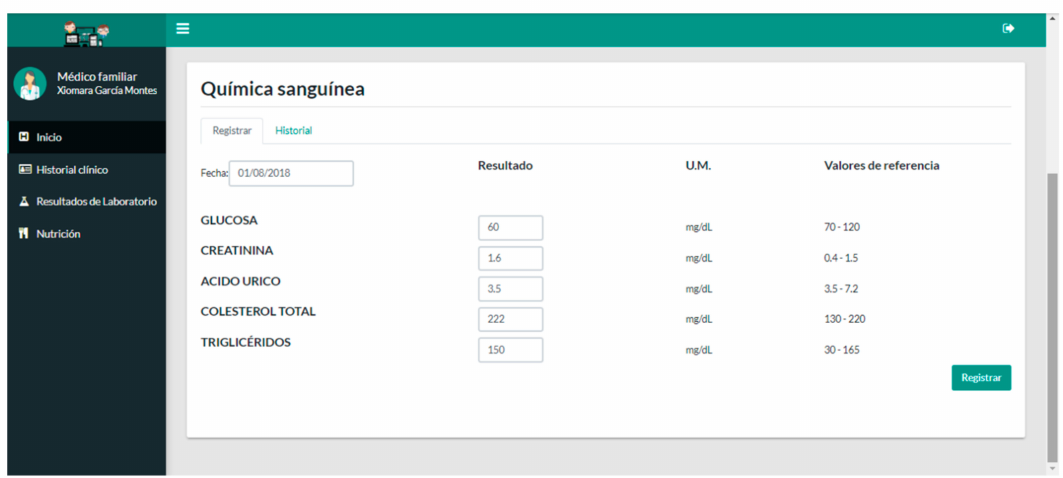
Figure 22. Physician application interface: Laboratory results module.